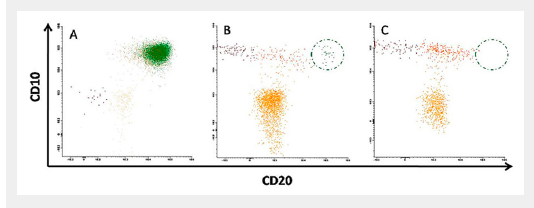
Minimal residual disease detection using flow cytometry. A. Patient diagnosed with a massive B-lineage acute lymphoblastic leukaemia clone characterised by CD10/CD20 double positivity (green) and bone marrow dysplasia. B. Same patient after chemotherapy. Bone marrow regeneration is confirmed by a high number of progenitors (yellow) and normal B cell differentiation is resumed (brown to orange). However residual disease was also detected (green). C. Normal bone marrow from healthy donor. 10 6 total events were acquired in each